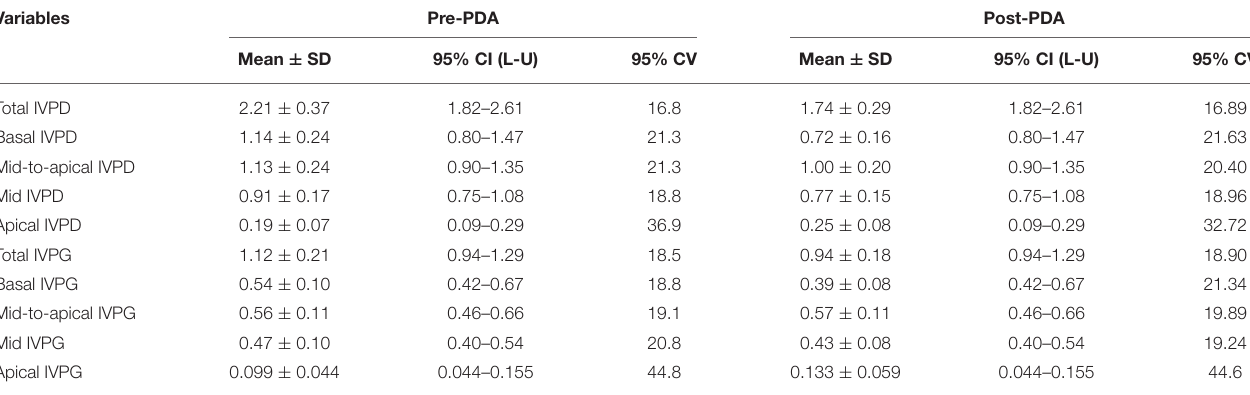
TABLE 2 | Variability and normality of CMME indices before and after PDA occlusion.